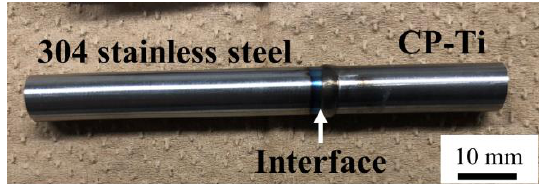
Figure 2. Appearance of the 304 stainless steel / CP-Ti JHDBed joint (axial pressure, bonding time, bonding temperature of 30 MPa, 15 s, and 1140 °C, respectively).